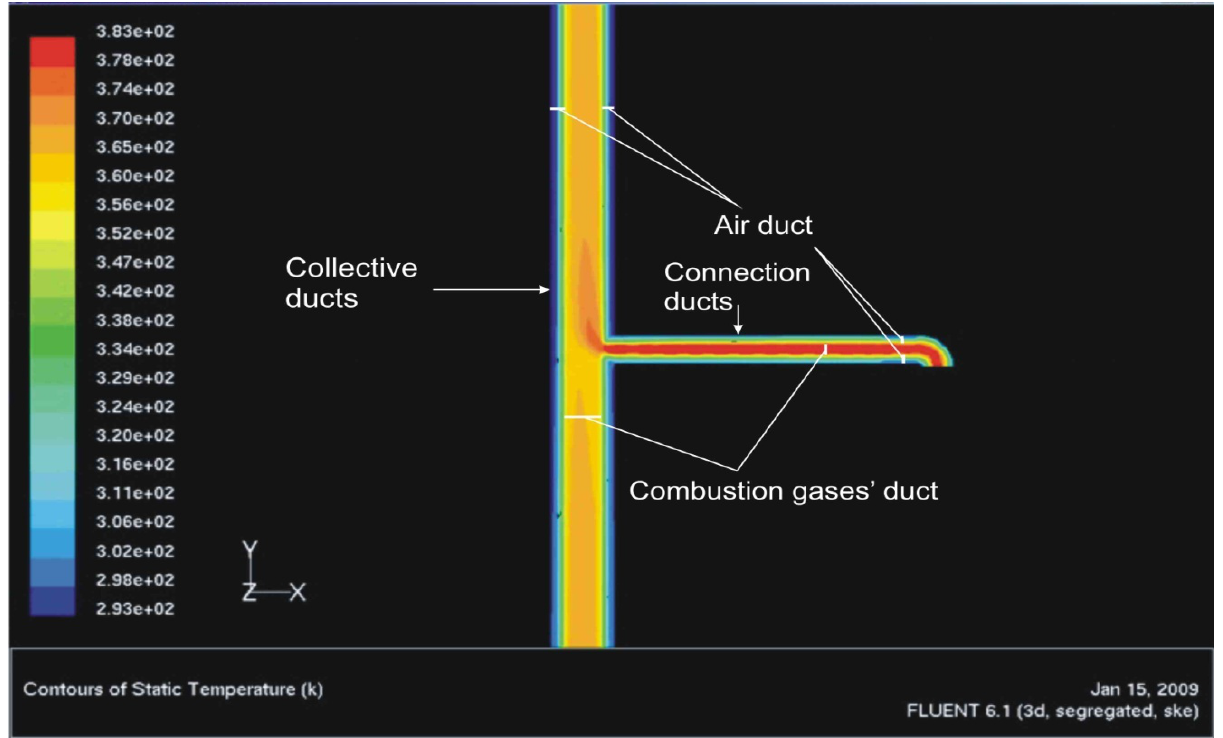
Figure 5. Sample temperature distribution [K] for a selected section of the collective chimney and air-supply duct